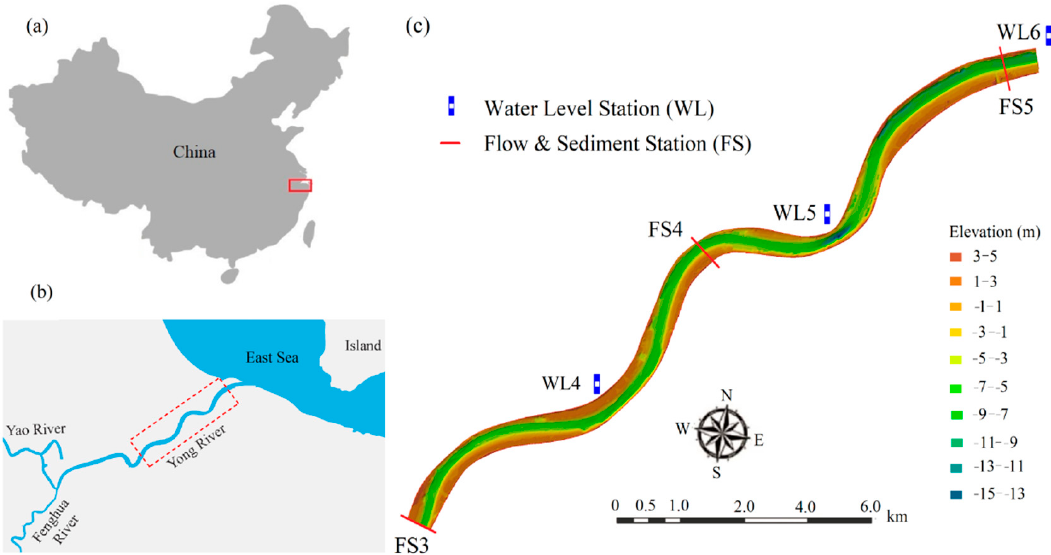
Figure 1. Study area: ( a ) Location; ( b ) examined meandering reach of the Yong River; ( c ) measurement stations of water levels (WL) and flow & sediment (FS).